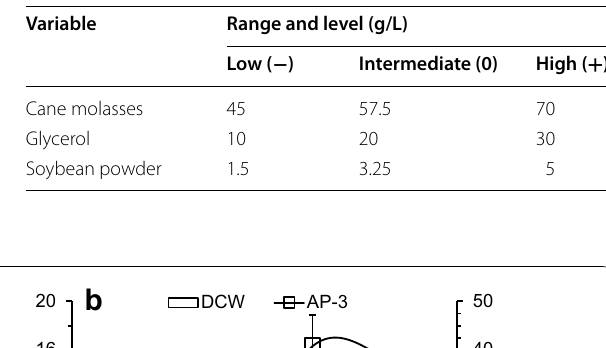
Table 1 Box–Behnken design for optimization of cane molasses, glycerol, and soybean